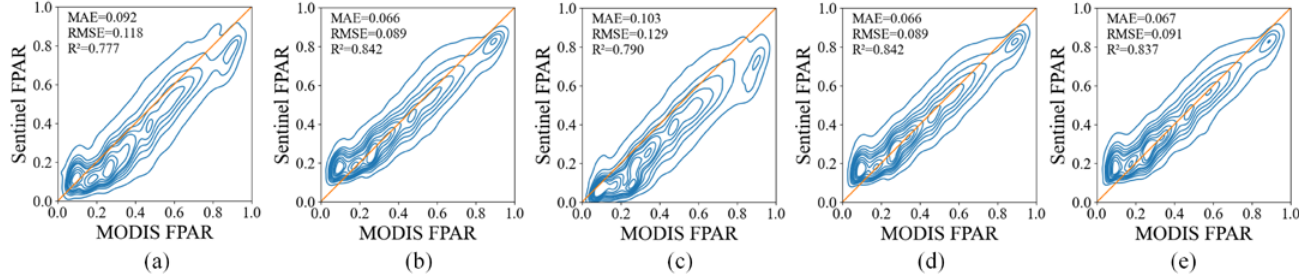
Figure 7. Two-dimensional density contour of MODIS FPAR vs. Sentinel FPAR retrievals. ( a ) SNAP FPAR at 10 m. ( b ) Scaled FPAR with three bands. ( c ) SNAP FPAR at 20 m. ( d ) Scaled FPAR with five bands. ( e ) Scaled FPAR with eight bands.